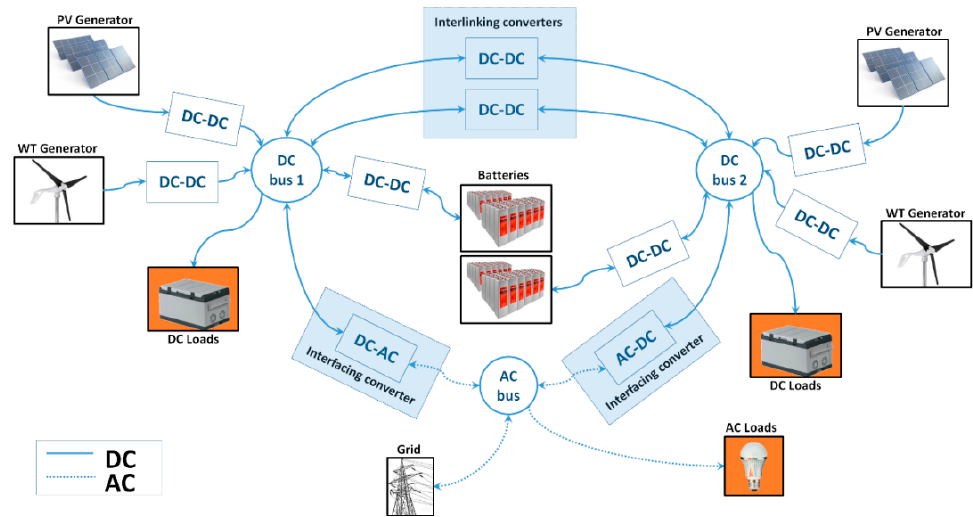
Figure 1. Proposed architecture for the hybrid microgrid.